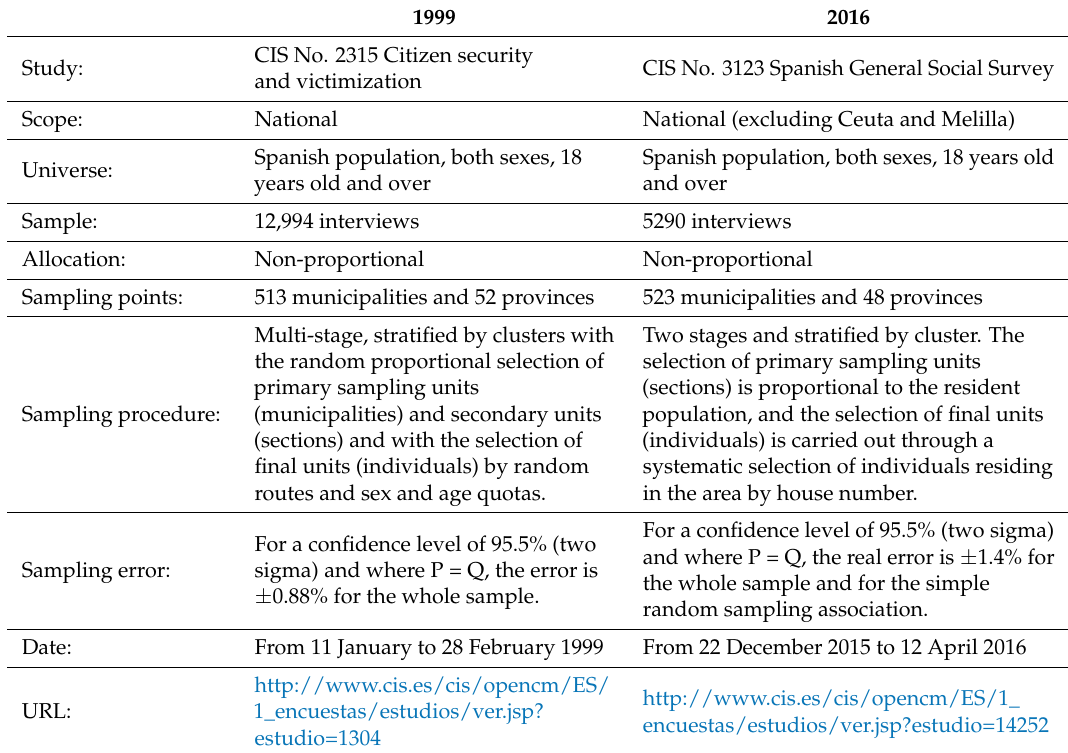
Table 1. Surveys of victimization in Spain (1999 and